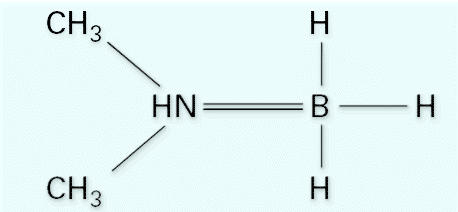
Chemical structure of DMAB [(CH3)2NHBH3] (BASF 2004).